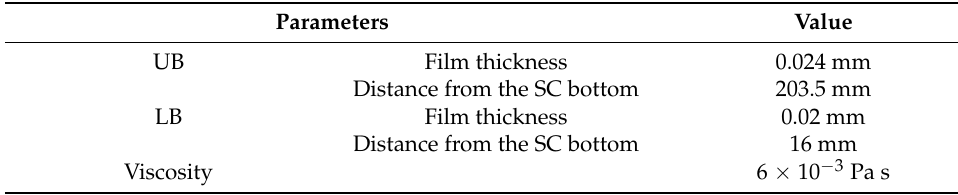
Table 4. Parameters of the journal bearings.